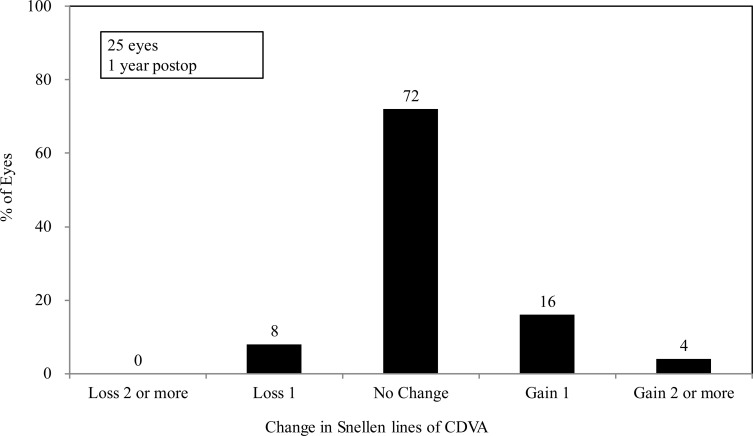
Changes in CDVA after implantation of an implantable collamer lens with a central hole.CDVA = corrected distance visual acuity.